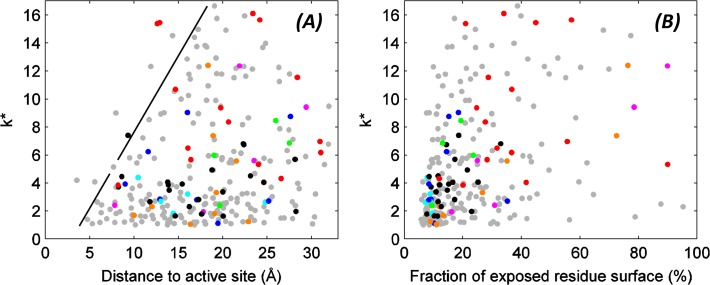
Effective number of substitutions versus distance to the active site and solvent exposure.Effective number of amino acids that appear at each position (k*) plotted versus the distance from its Cα atom to the active site (A) and against the fraction of amino acid surface exposed to the solvent (B). The position of the active site was defined as the average position of the Ser70, Lys73 and Glu166 Cα atoms; surface exposure was computed with the POPS webserver [48,49] based on the X-ray structure deposited under PDB entry 1XPB [50]. Dot colors correspond to correlations against the most often matched properties: blue for volume, cyan for volume/(P(helix)+P(sheet)), green for steric hindrance, dark green for steric hindrance / P(sheet), red for hydrophobicity, magenta for log(solubility) x hydrophobicity, orange for flexibility x hydrophobicity. Black dots represent correlations with FoldX predictions. Gray dots correspond to the rest of the residues (with other or no detected correlations). The line drawn in panel A arbitrarily indicates how the maximum possible k* increases with distance to the active site.